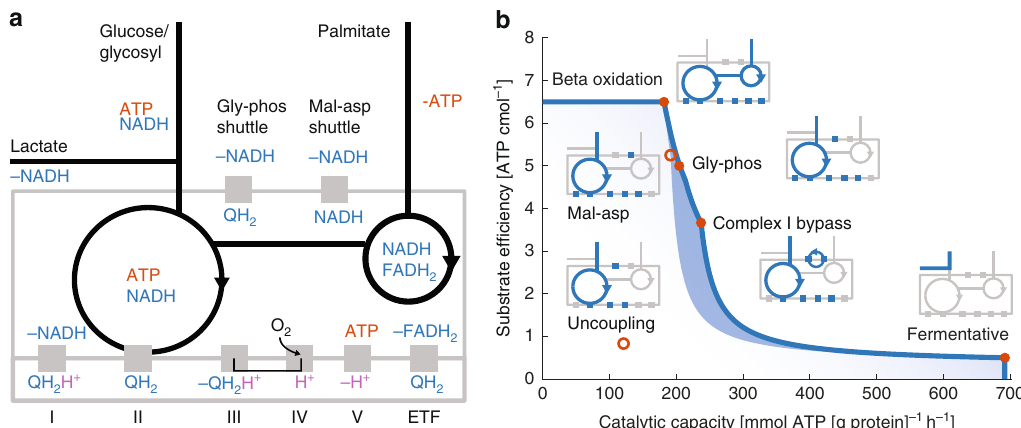
Fig. 1 Bypass of complex I is a Pareto optimal metabolic mode. a Schematic representation of the model of intermediary metabolism, including beta- oxidation. b The model identi fi es four optimal ( fi lled circles) metabolic modes with decreasing substrate ef fi ciency (ATP per cmol), but increasing catalytic capacity (ATP[g protein] − 1 h − 1 ). These consisted of two fully oxidative modes on palmitate and glycogen, respectively, followed by a partially coupled oxidative mode (bypass of complex I), and a fully fermentative mode, two suboptimal metabolic modes are also shown for reference (open circle). The active pathways in each mode are indicated (in blue) in the schema corresponding to ( a ). Linear combinations of adjacent modes form a Pareto front for the trade-off between catalytic capacity and substrate ef fi ciency. The mode including Complex I bypass increases the feasible area (indicated with blue shading), allowing a higher substrate ef fi ciency than otherwise possible at high catalytic